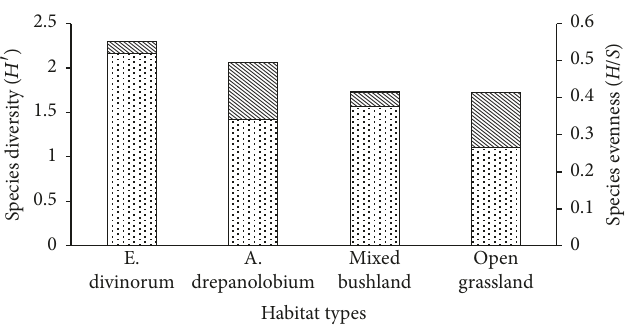
Figure 2: Wildlife species diversity (left 𝑦 axis) and wildlife species evenness (right 𝑦 axis) in different habitats in